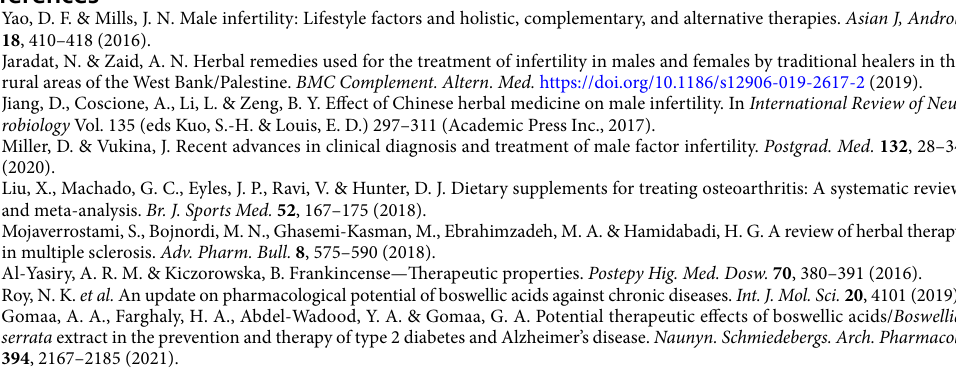
Table 3. The cDNA cycle was as follows; priming—5 min at 25 °C, RT—20 min at 46 °C, RT inactivation—1 min at 95 °C. Reaction volume for real-time PCR was 25 µL (SYBR mix-12.5 µL, water-9.5 µL, Forward primer 1 µL, Reverse primer 1 µL, cDNA 1 µL). Real-time PCR was performed in a Rotor-gene machine (Qiagen). QuantiFast SYBR green master mix (Qiagen) was used and primers were validated with SYBR reactions for amplification and melt curves. The concentration of primers used in real-time PCR was 200 nM. No primer had self-annealing or self-dimerization property and they had Tm near 60 °C. Reactions were done at 60 °C, PCR initial activa- tion step—5 min at 95 °C, denaturation at 95 °C—10 s, annealing at 60 °C—20 s, extension—20 s at 72 °C. The number of cycles performed was 40 and the average of duplicated reactions was taken for analysis. The ΔΔCt method was used for calculating fold changes.